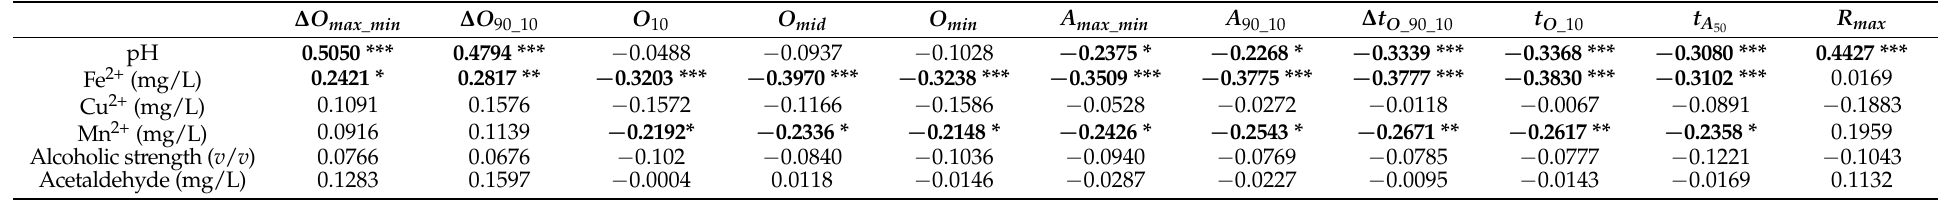
Table 4. Pearson correlation coefficients between the reconstitution compounds concentrations and consumption kinetics parameters of